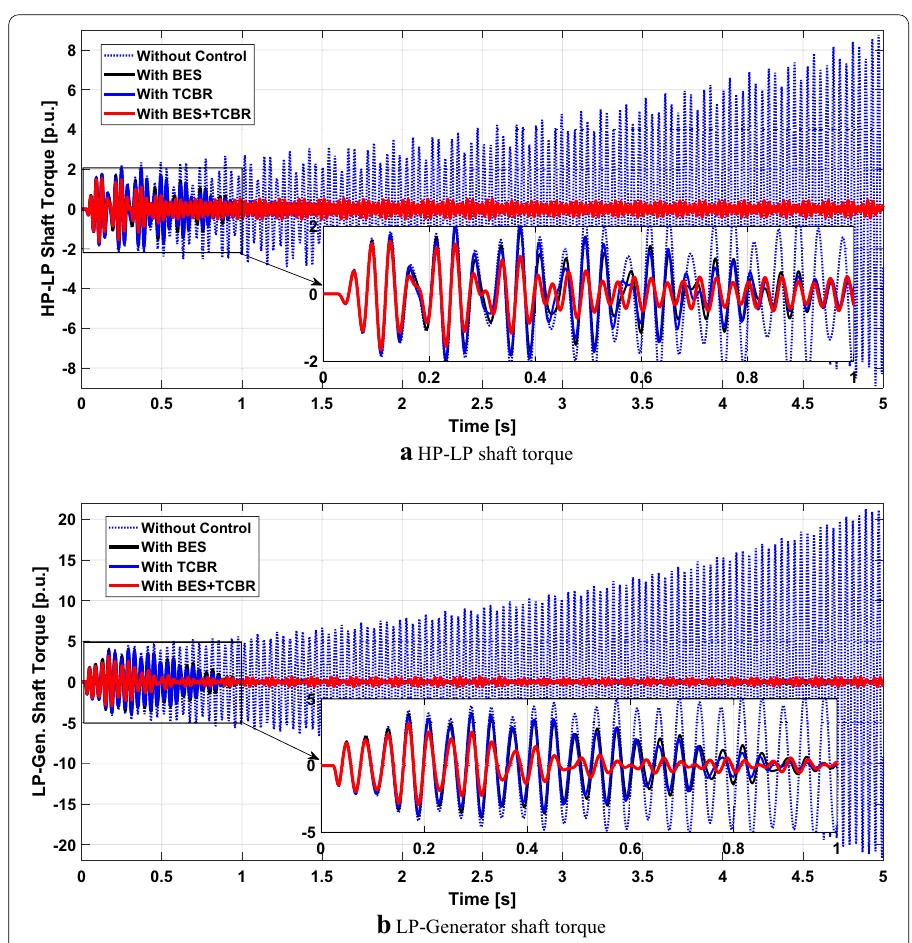
Fig. 7 Responses of the SSR torque without and the with the propositioned